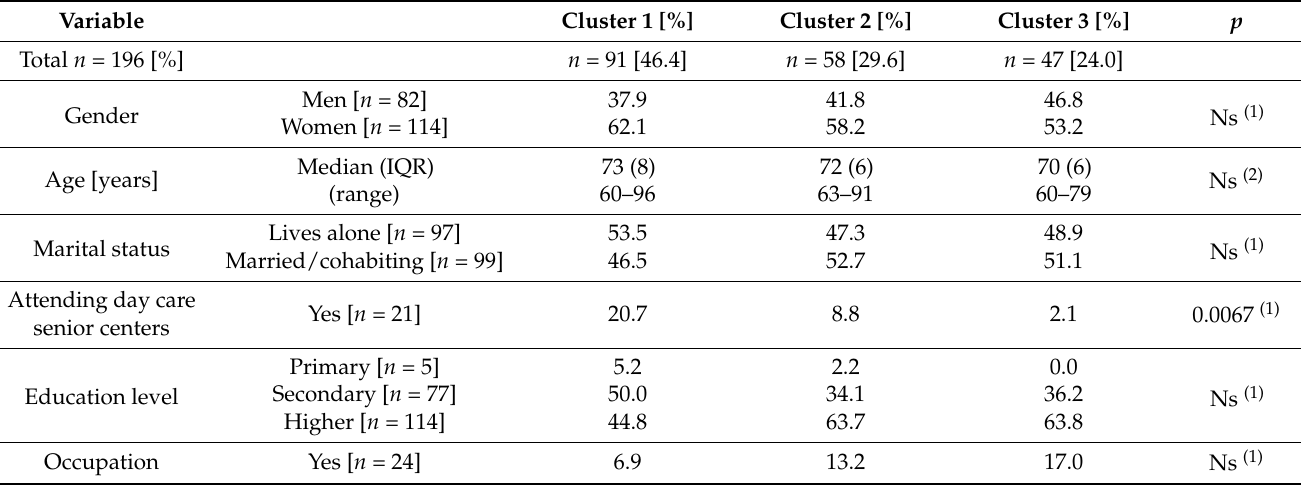
Table 1. Sociodemographic characteristics of the study population by